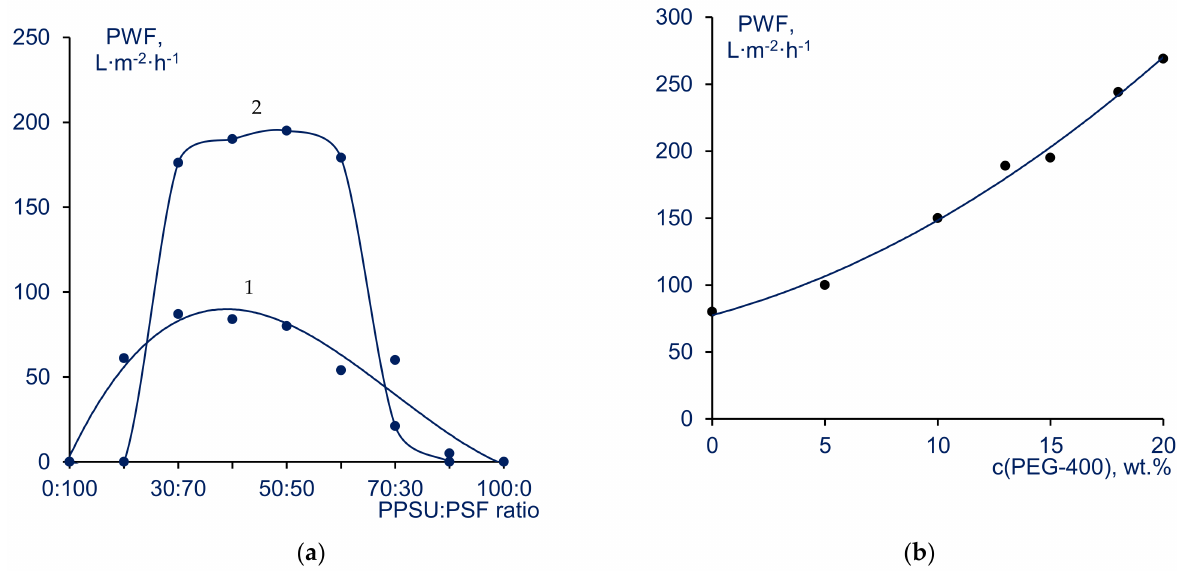
Figure 8. Pure water flux (PWF) of blend PPSU-PSF membranes. ( a )—dependence of PWF of membranes on the PPSU:PSF blend ratio, PEG-400 concentration in the casting solution: 1–0% PEG-400 (series A); 2–15 wt% PEG-400 (series B); ( b )— variation of PWF of membranes (ratio of PPSU:PSF is 50:50) with PEG-400 concentration in the casting